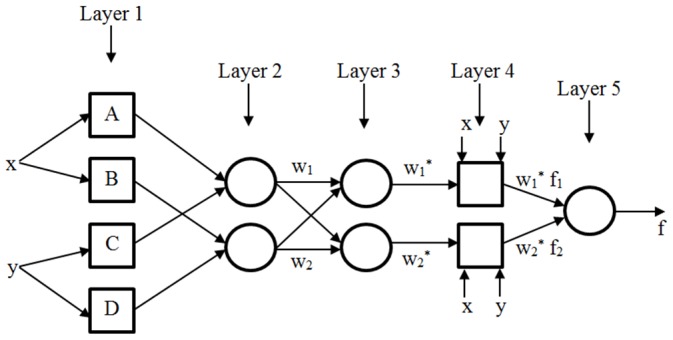
ANFIS structure.